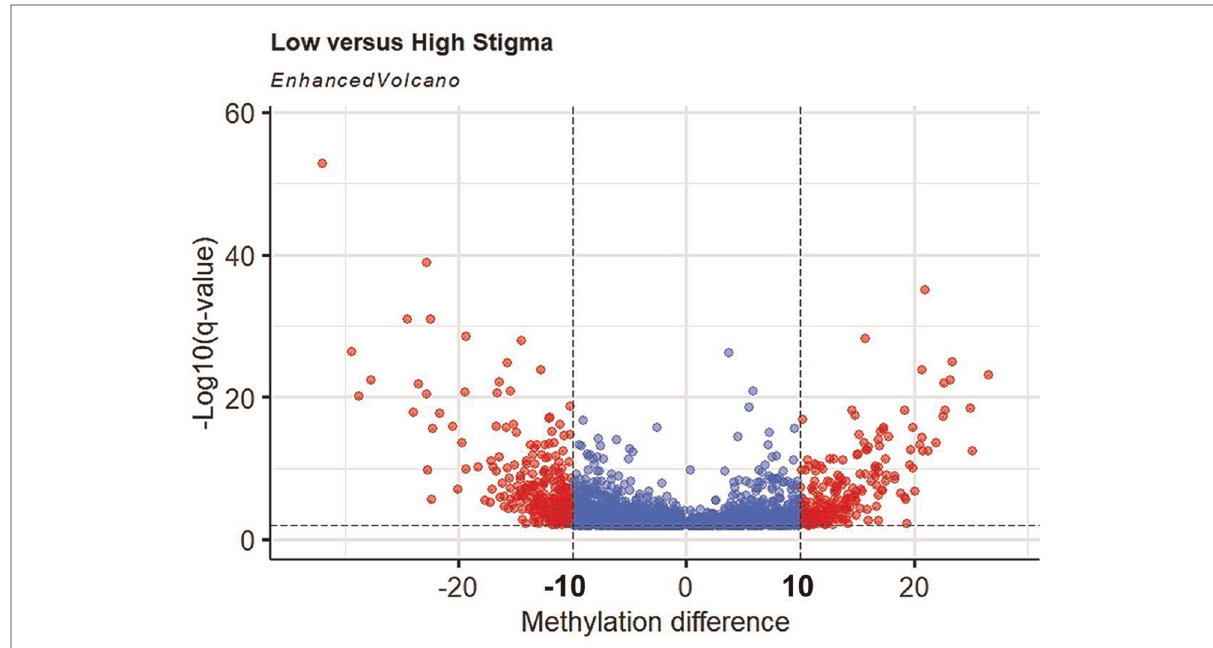
FIGURE 3 Volcano plot of hypermethylated and hypomethylated CpGs in high stigma compared to low stigma in adults with non-speci fi c cLBP. The magnitude of the statistical signi fi cance between methylation differences are displayed as positive or negative ( x -axis) with low stigma as reference point vs. high stigma, against − log10( q -value) on the y -axis. Black horizontal dashed line indicated a q -value threshold of 0.01 and vertical Black line indicates methylation difference thresholds of 10% to − 10%. Red dots are DMLs ( q <0.01 and methylation difference ≥ 10).